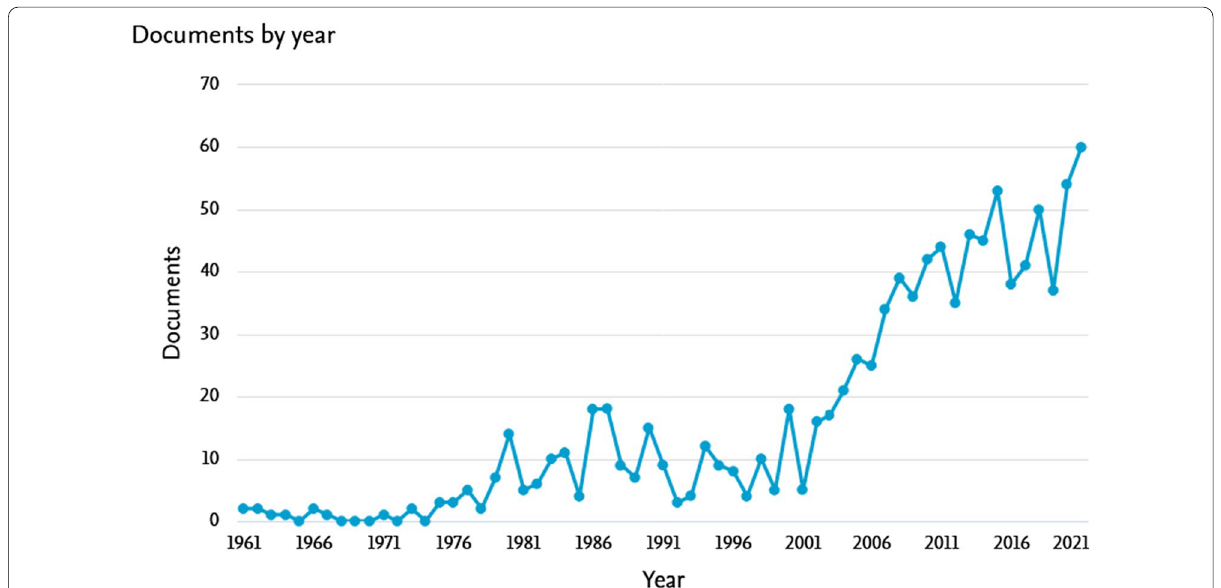
Fig. 3 Progress of research on C. edulis as per the number of published articles (1961–2021)